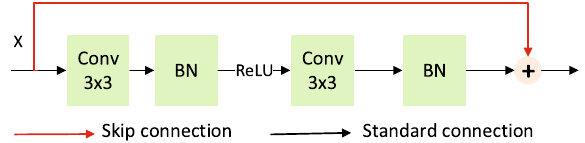
Figure 5. ResNet module.